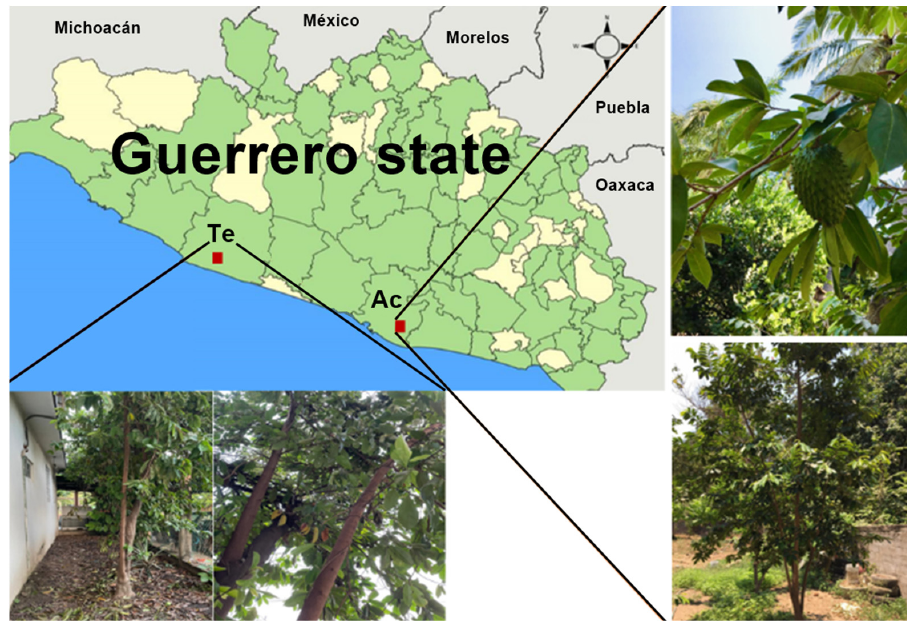
Figure 1. Map of Guerrero state showing Acapulco ( Ac ) and Tecpan de Galeana ( Te ) regions where the leaves of A. muricata were collected.